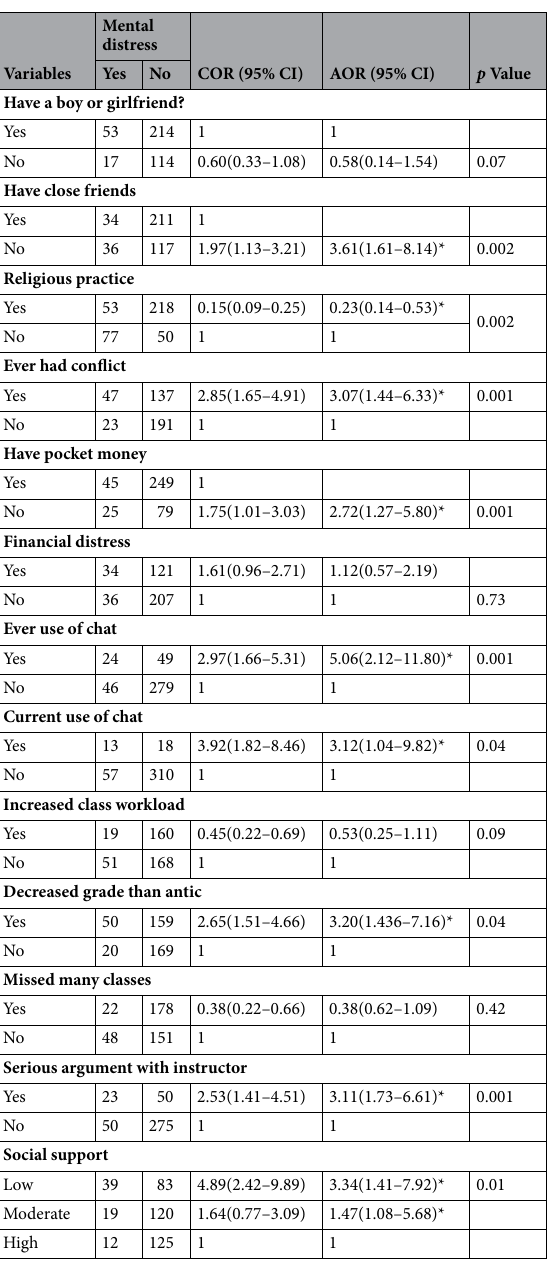
Table 2. Bivariable and multivariable logistic regression analysis of factors associated with mental distress; (n = 398). *Statistically significant at p <